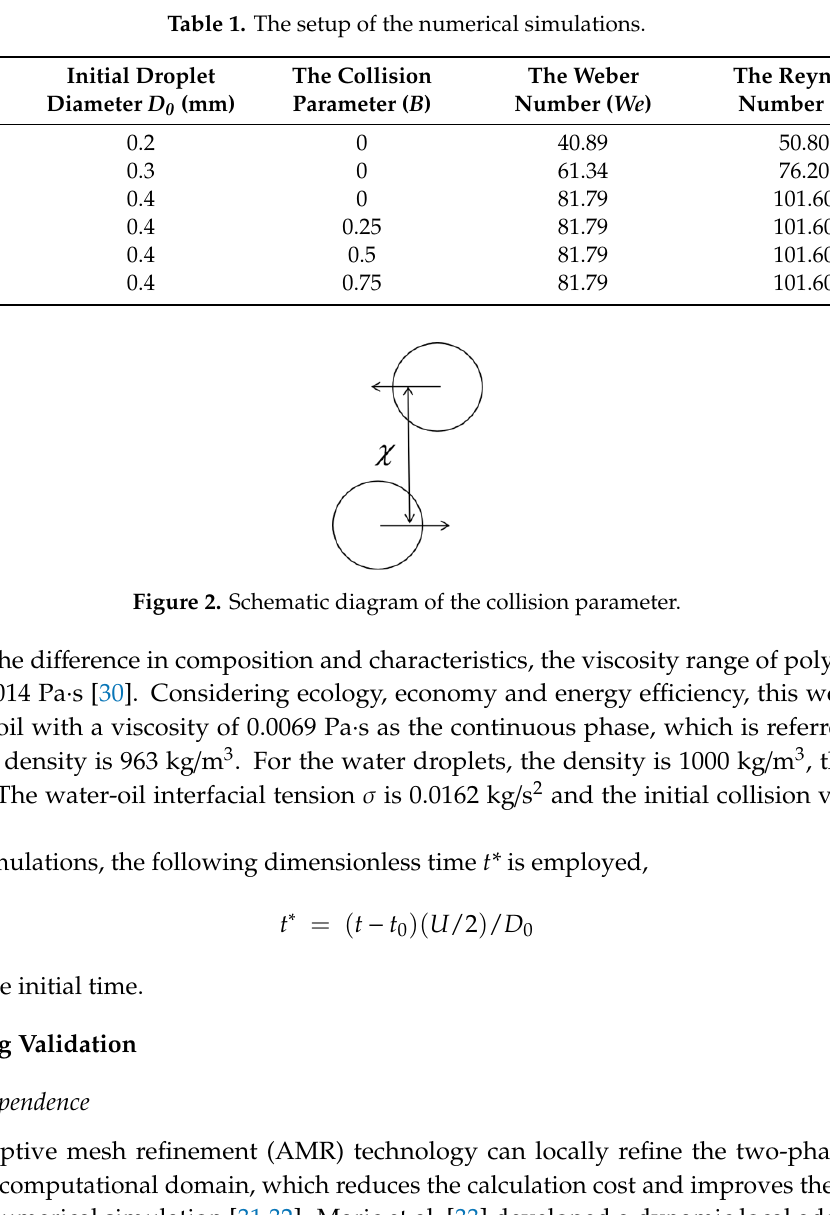
Figure 4. Verification of the grid independence under three different grid resolutions. It can be observed that in the early stages of the collision process, the droplet shapes are similar for different mesh resolutions. In the later stages of the collision process, when the grid resolution is 64/ 0  xD